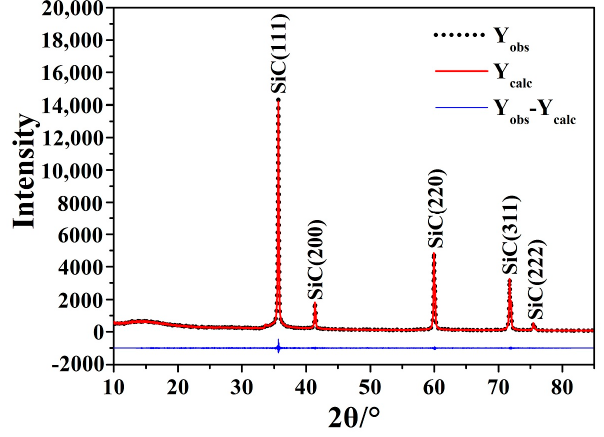
Figure 6. Profile plot for Rietveld refinement against XRD data of D 5.